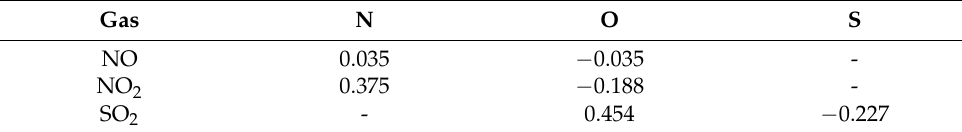
Table 2. Single atom charges of gas molecules in the gas phase.